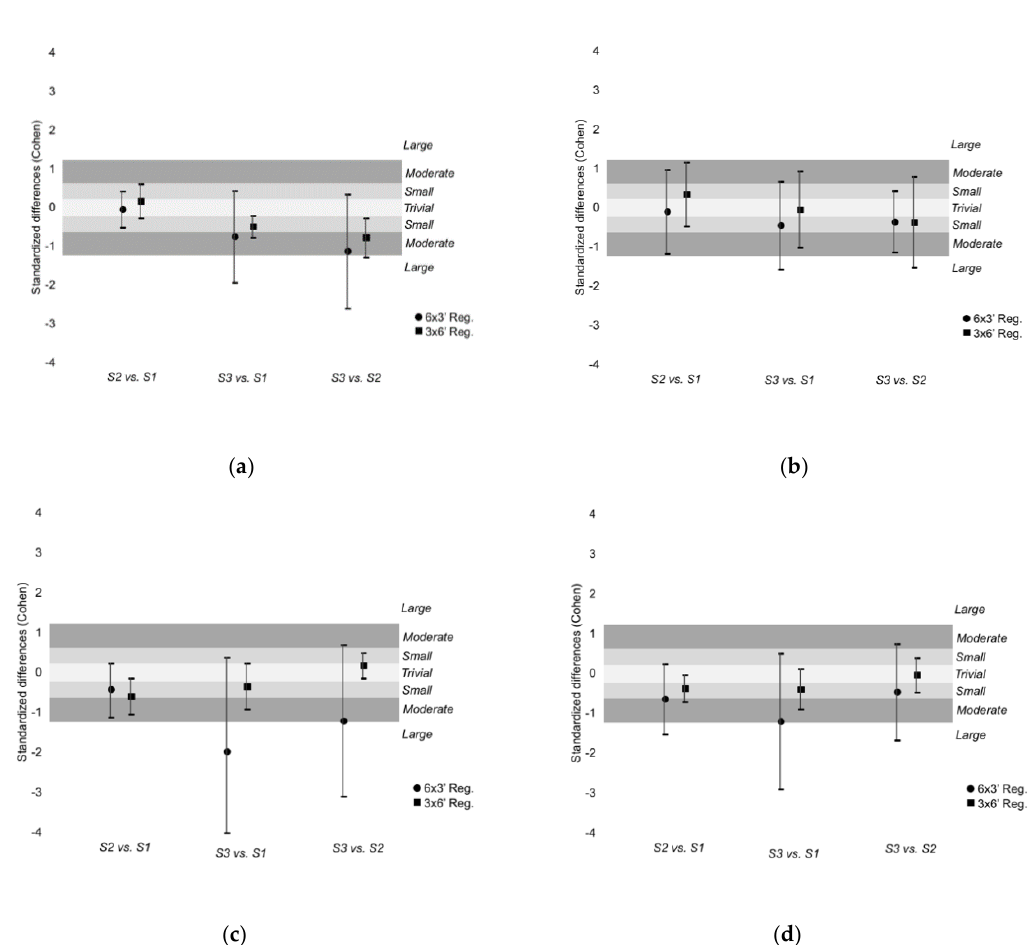
Figure 1. Standardized difference (Cohen) between sets in ( a ) RPE; ( b ) HRmean; ( c ) Total Distance; and ( d ) Player Load. The six sets of the 6 × 3 ’ regimen were grouped in three sets (S1: mean of set 1 and 2; S2: mean of set 3 and 4; S3: mean of set 5 and 6) to a better visualization and analysis. Standardized value direction depends on the relationship A-B.